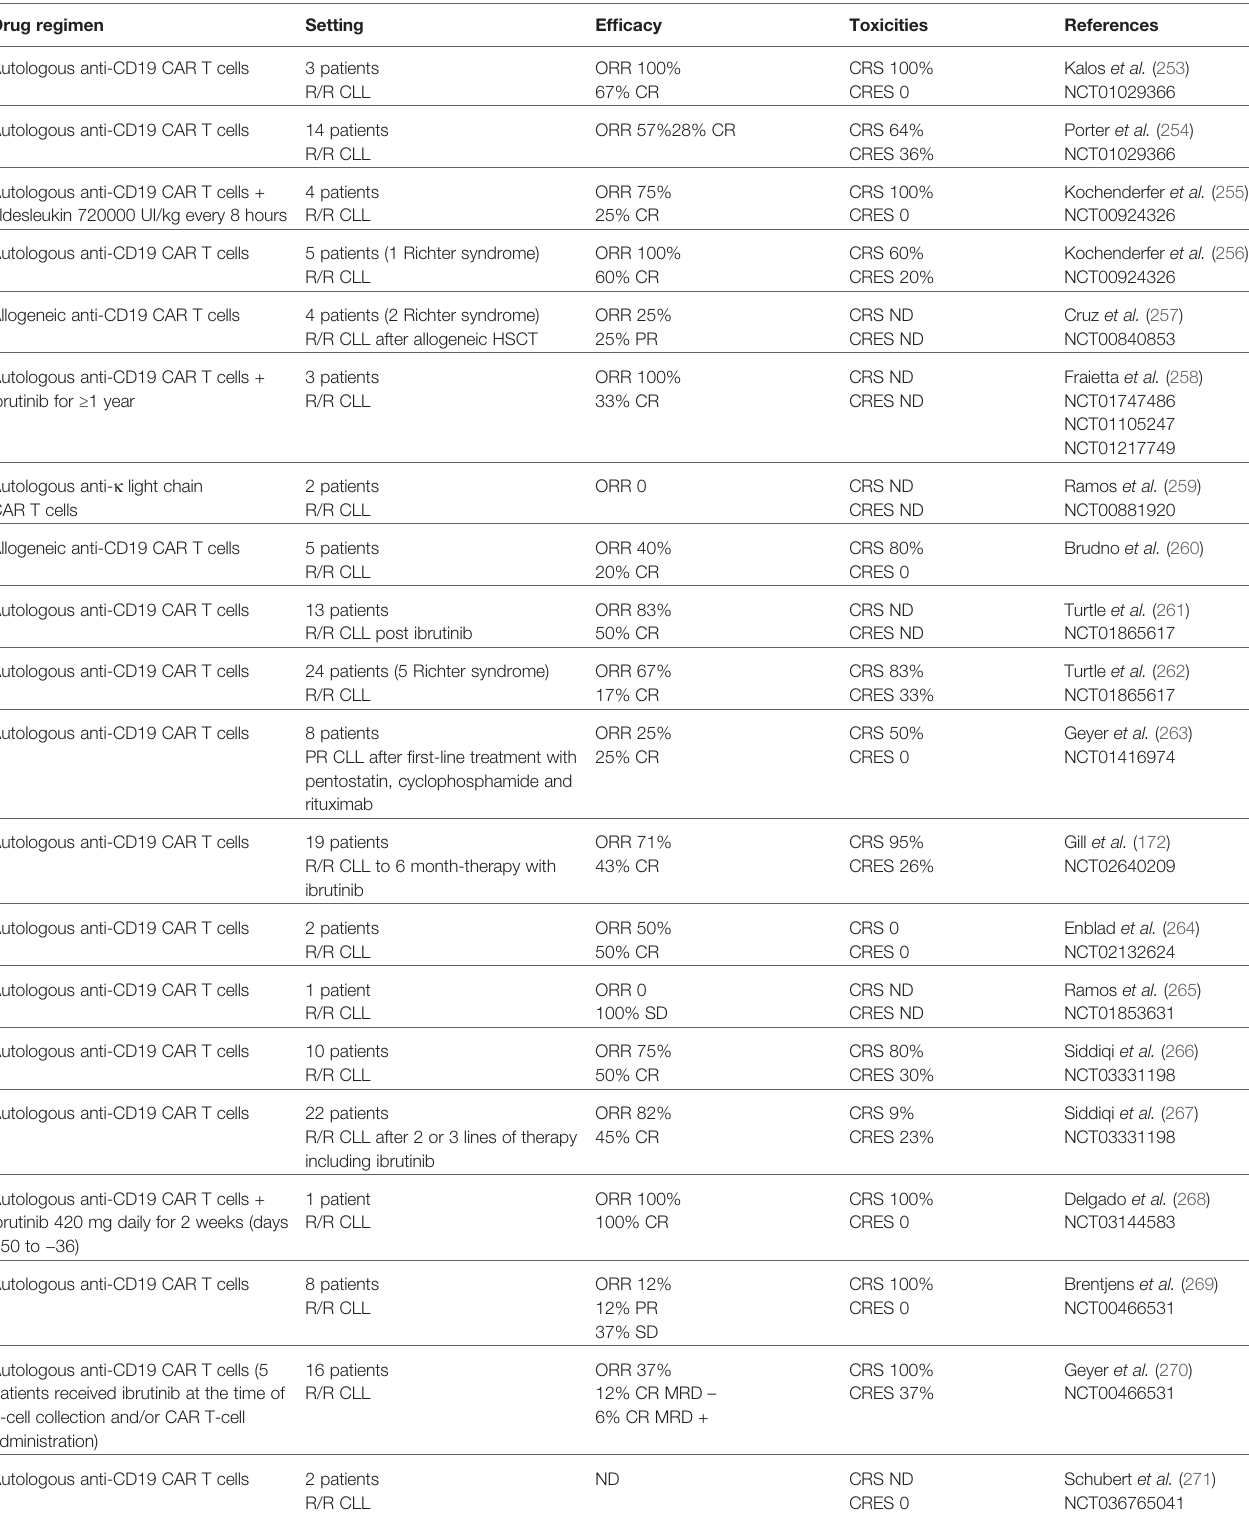
TABLE 2 | Clinical trials evaluating the ef fi cacy and toxicity of CAR T- and CAR NK-cell treatment in CLL